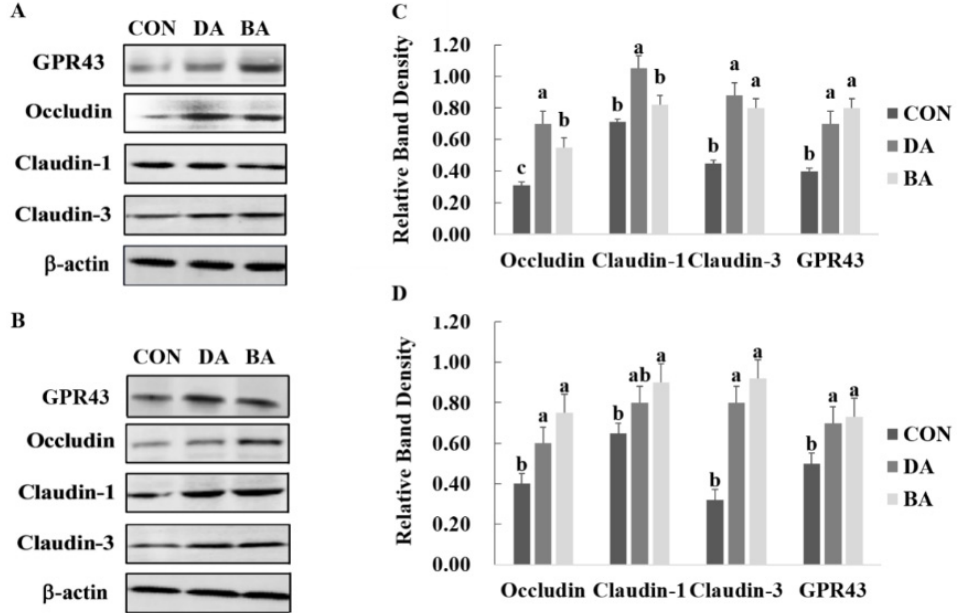
Figure 4. Effects of sodium decanoate and sodium butyrate on tight junction proteins and GPR-43 expressions in the ileal and colonic mucosa of C57BL/6 mice (Exp.2). ( A ) Expression of tight junction proteins and GPR-43 in the ileum. ( B ) Expression of tight junction proteins and GPR-43 in the colon. ( C ) Relative band density of tight junction proteins and GPR-43 in the ileum. ( D ) Relative band density of tight junction proteins and GPR-43 in the colon. A total of 36 mice with weaning age of 28 d were allocated into three dietary treatments randomly, which are control (CON), 5 g/kg sodium decanoate (DA), and 5 g/kg sodium butyrate (BA) diets. At the end, the intestinal mucosa sample from each mouse was collected from the approximately middle positions in the ileum and colon to evaluate the expression of tight junction proteins and G protein-coupled receptor-43. a,b Significant differences are indicated by different lowercase letters ( p < 0.05).